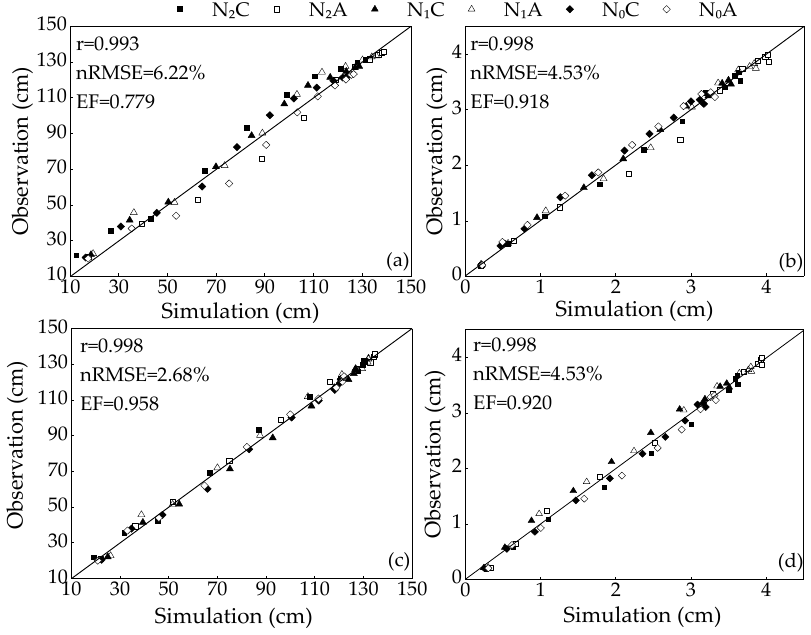
Figure 4. Observed and simulated values of tomato plant height and LAI of logistic ( a , b ) and Richards models ( c , d ) under different treatments.